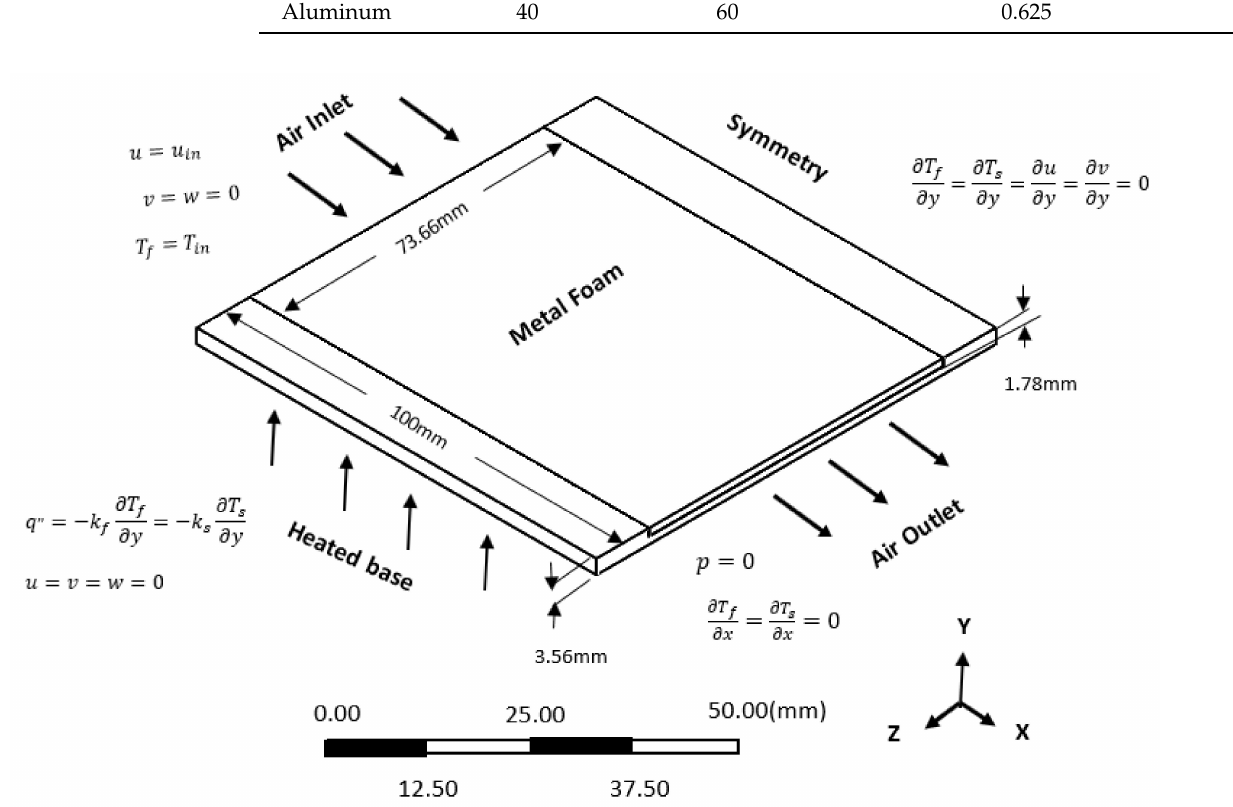
Figure 4. A drawing of the 3-dimensional heat transfer problem that was solved in ANSYS-CFD with dimensions and boundary